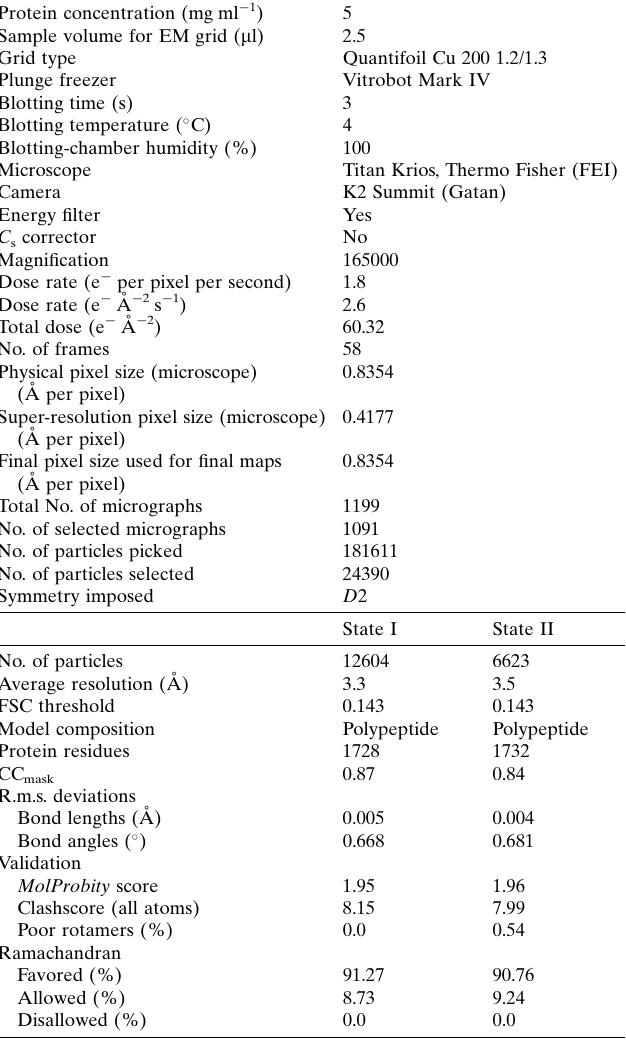
Table 1 Sample-preparation, data-collection and refinement